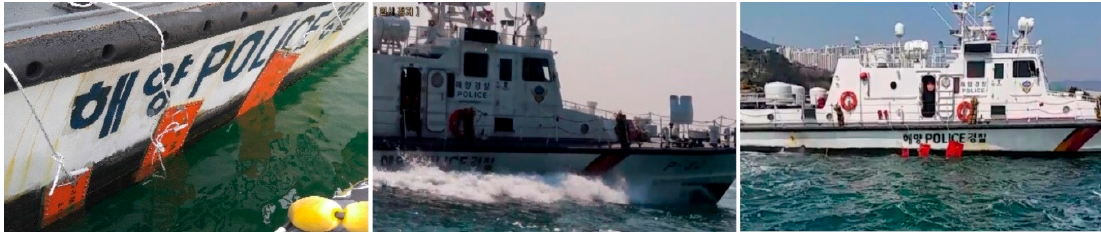
Figure 12. Emergency liquid spill stoppers during attachment tests when sailing. From the left to right: Before sailing, during sailing, after sailing.